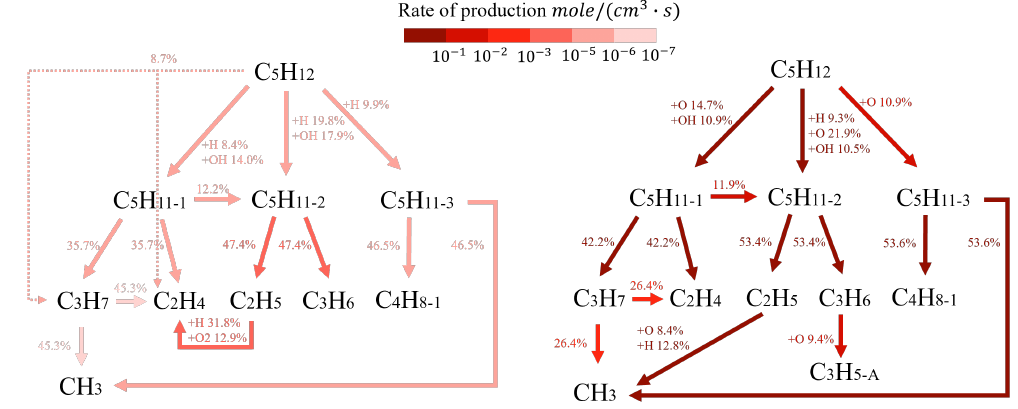
Figure 16. Fuel consumption and subsequent pathways based on the rate of production analysis when the conversion of pentane is 50%. The left photograph represents combustion without plasma, and the right photograph represents combustion with